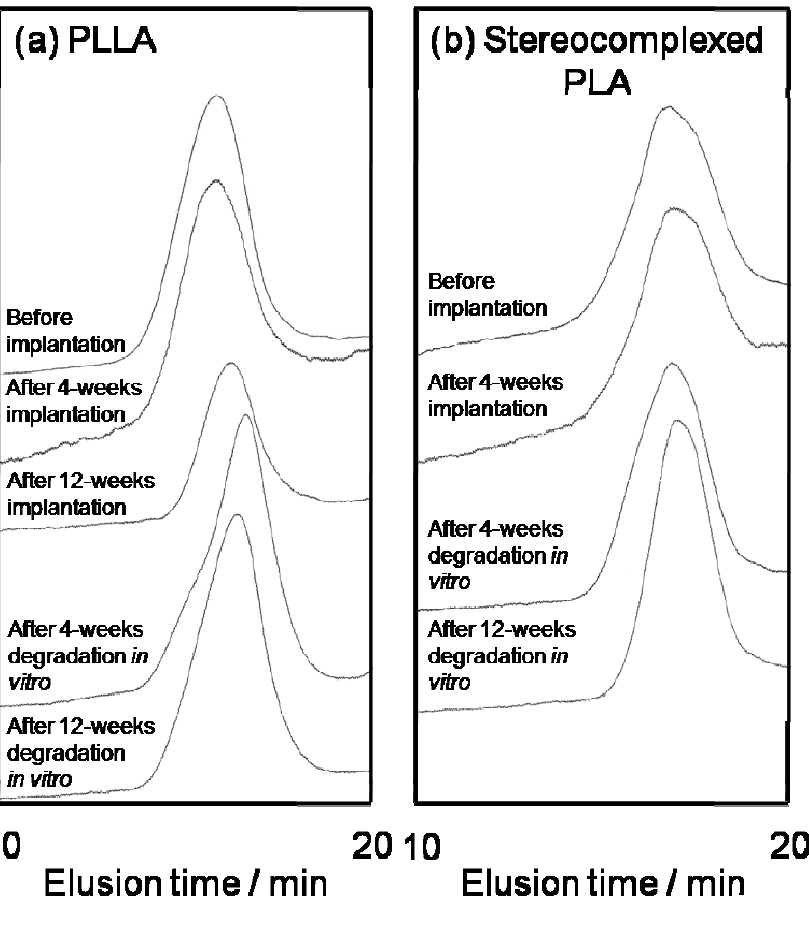
Figure 14. GPC elusion profiles of PLLA and stereocomplexed PLA nanofibers. (a) Before and after 4-weeks of implantation in vivo . (b) Before and after 4- and 12-week in vitro degradation [55].